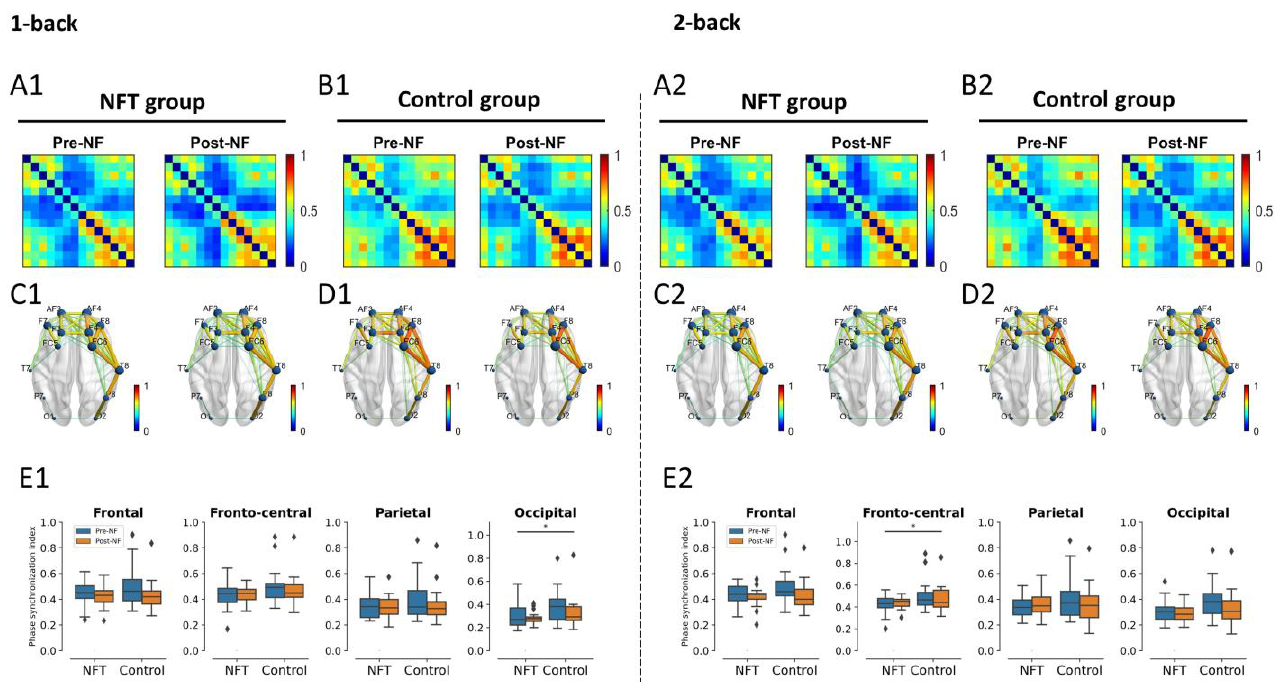
Figure 10. Alpha band functional connectivity (* p < 0.05). Connectivity matrices shown in ( A1 ) for NFT group and ( B1 ) for control group and brain connections in ( C1 ) for NFT group and ( D1 ) for control group in 1-back condition. Similarly, connectivity matrices shown in ( A2 ) for NFT group and ( B2 ) for control group and brain connections in ( C2 ) for NFT group and ( D2 ) for control group in 2-back condition. The box plots in ( E1 , E2 ) show the phase synchronization index in different brain lobes in 1-back and 2-back conditions, respectively. The colour bars of the connectivity matrices and brain connections represent the strength of synchronization between the EEG channels. It ranges from 0 (no synchronization) to 1 (full synchronization). The diamond shape in the box plots represents the outliers in the data.